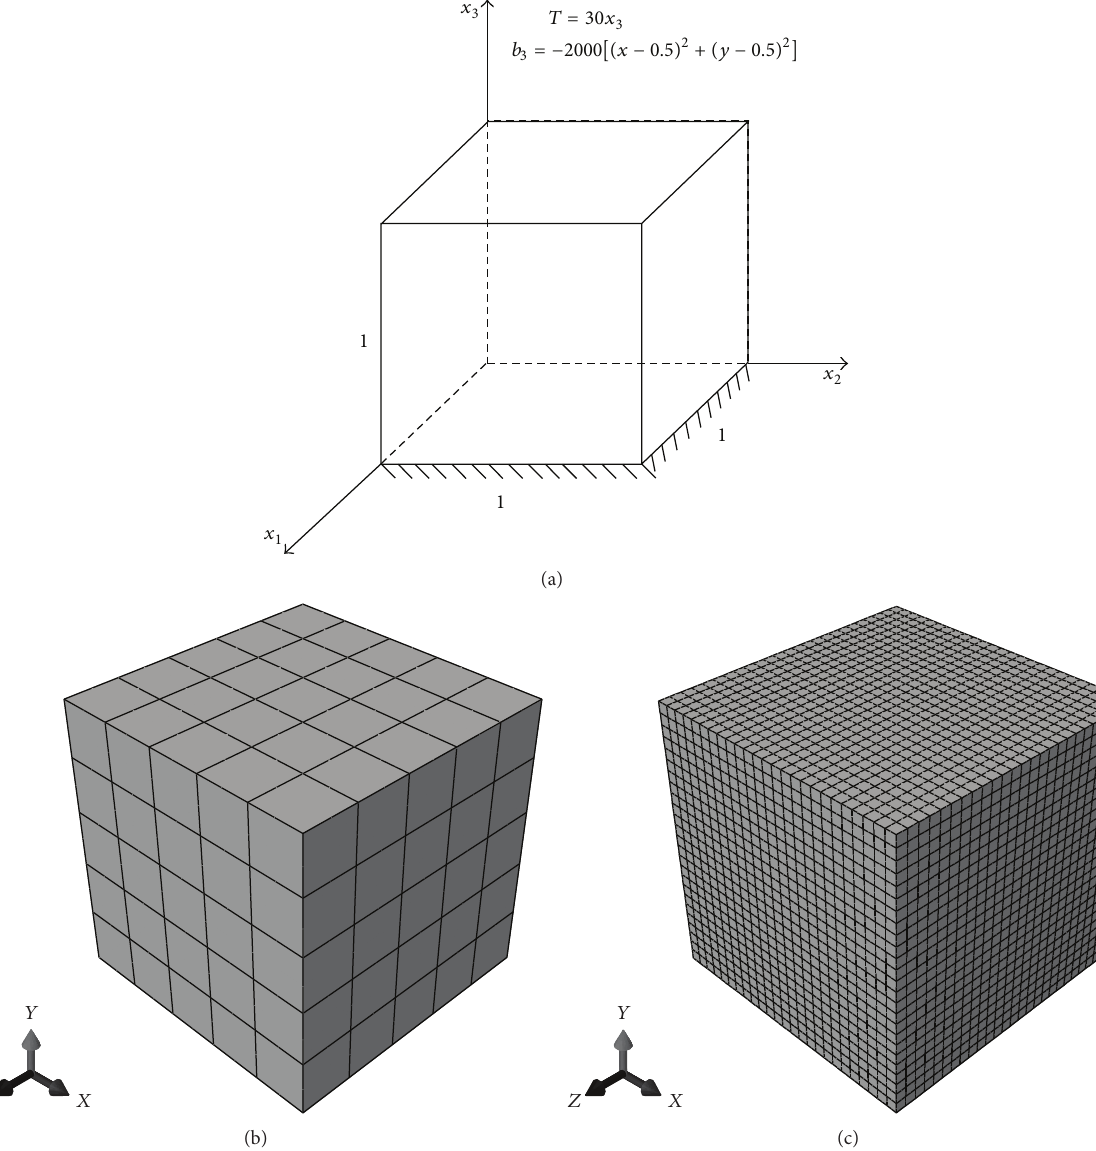
Figure 15: (a) Schematic of the 3D cube under arbitrary temperature and body force, (b) mesh used by HFS-FEM (125 20-node brick elements), and (c) mesh for ABAQUS (8000 C3D20R